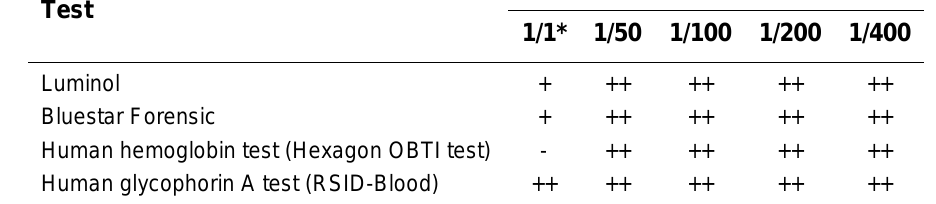
Results of the Luminol, Bluestar Forensic, Human Hemoglobin, and Human Glycophorin A Tests on Bloodstains Washed in Cold Water with Sodium Percarbonate to Different Concentrations (B